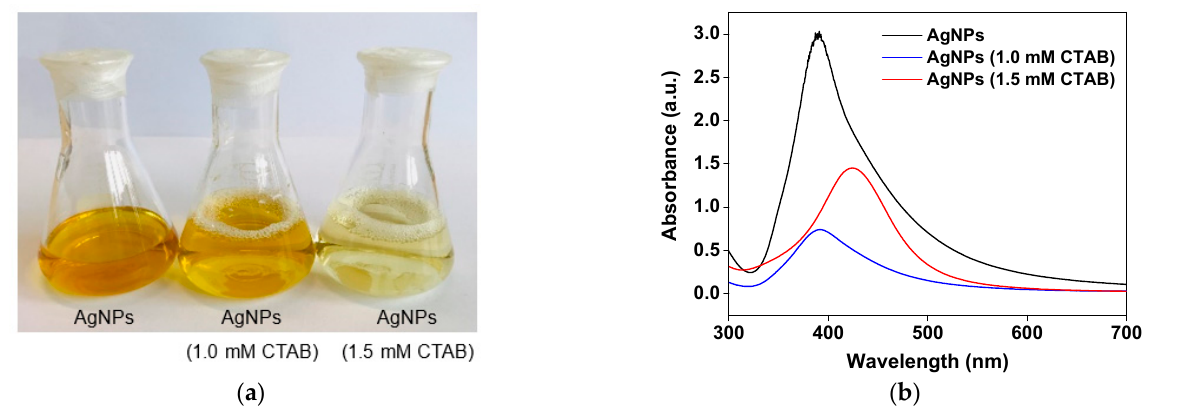
Figure 1. ( a ) Digital photographs of the solutions of Ag nanoparticles synthesized without the use of CTAB, with 1.0 mM CTAB and 1.5 mM CTAB. ( b ) UV–vis spectra of the AgNPs (1.0 mM CTAB), AgNPs (1.5 mM CTAB) and AgNPs with- out CTAB.